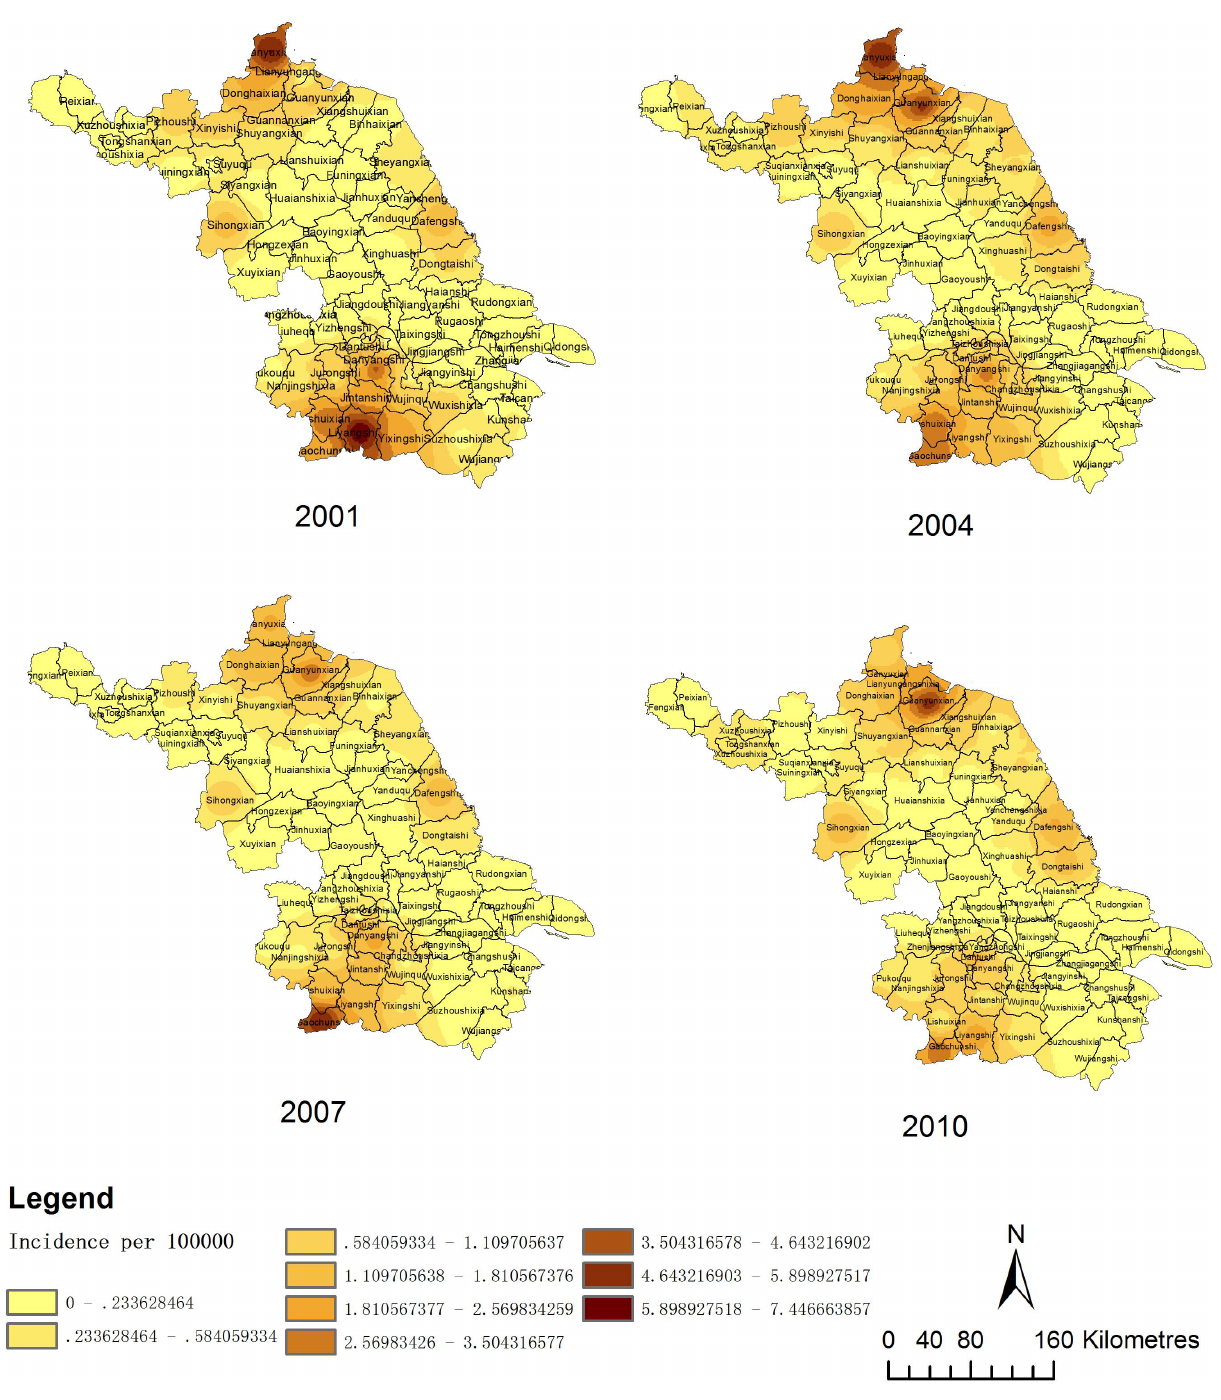
Figure 1. Interpolated maps of HFRS by IDW in Jiangsu in 2001, 2004, 2007 and 2010. The incidence of HFRS per 100,000 residents is shown in the map. The incidence of HFRS has a positive relationship with color depth.